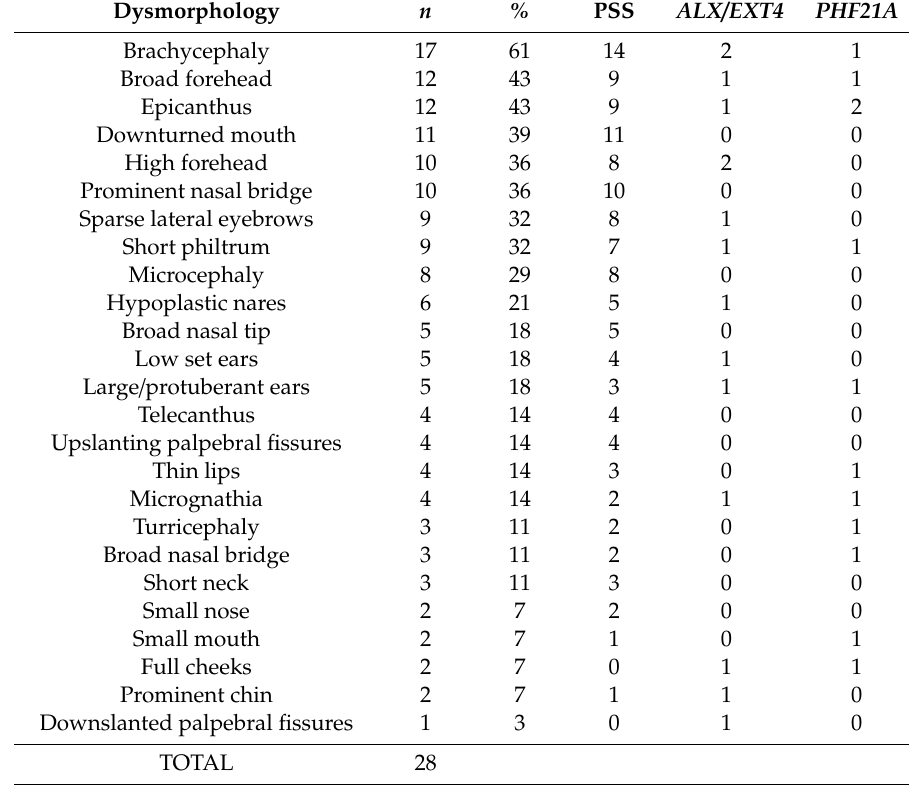
Table 2. Dysmorphology of PSS reported patients in the literature. Dysmorphology